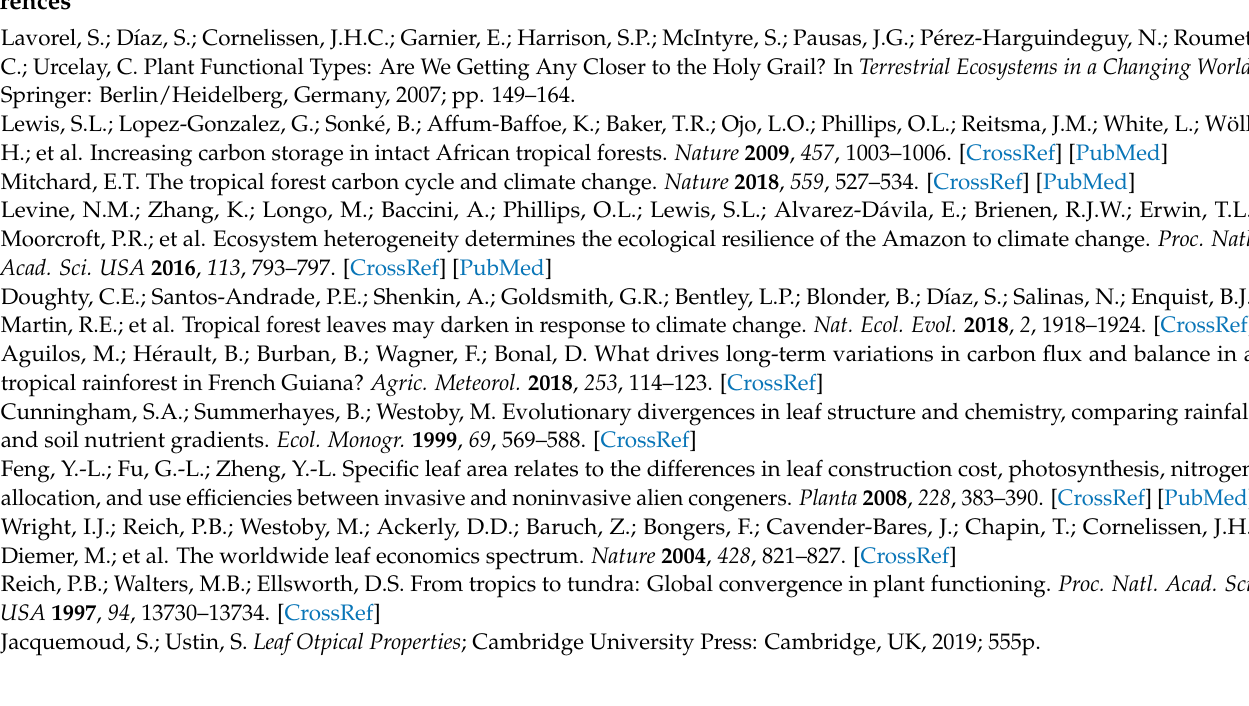
Figure S1. Correlation matrix of optical traits; Figure S2. Clustering in the bivariate factor space for the productivity ecosystem function; Figure S3. Clustering of the complete factor space; Figure S4. Altitudinal distribution of P-TFTs along the elevation gradient Figure S5; Cross-correlation matrix (Spearman’s rho) of the R-TFT VIS and NIR and albedo with the median values of the functional traits; Figure S6. Leaf geometry of the R-TFT clusters; Figure S7. Altitudinal distribution of R-TFTs along the elevation